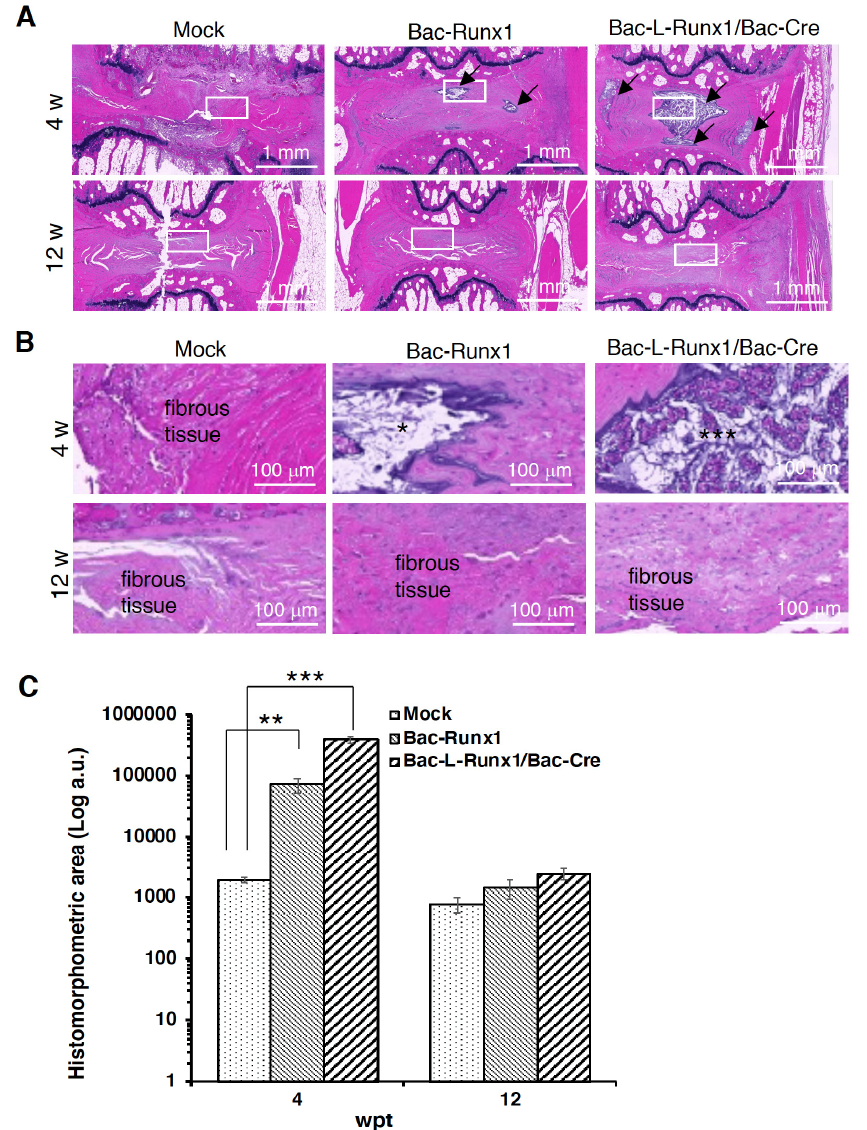
Figure 7. Histological examination of disc degeneration transplanted with BV transduced BMSCs and histomorphometric analysis. ( A ) Representative H&E staining at low magnification. Arrows indicate the gelatinous materials in the disc core. ( B ) H&E staining showed the area magnified from the solid line box at ( A ). Stars indicate the jelly-like materials secreted from NPs. ( C ) Histomorphometric analysis of gelatinous materials in H&E staining from 3 groups. Five sections in the middle part of serial disc sections from each group were picked up for analysis. (Weeks post-transplantation, wpt) ( n = 3) ** p < 0.01; *** p < 0.001.